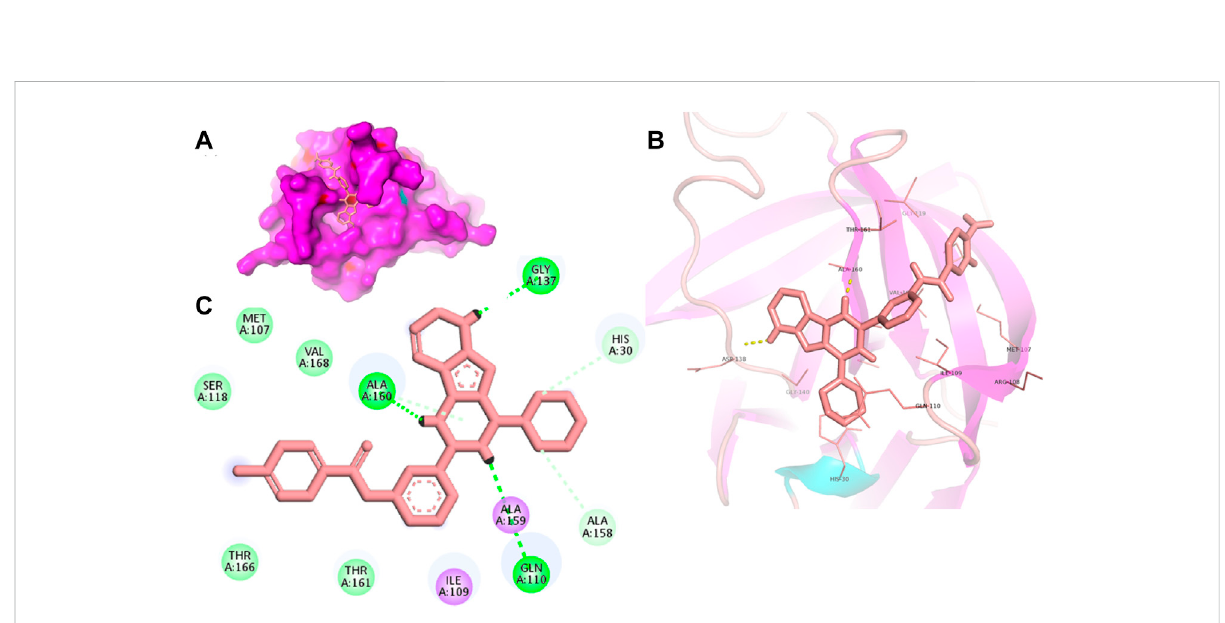
FIGURE 4 Surface view of YM201636 in the 3CLP binding pocket (A) , 3D (B) and 2D (C) interacting residues of 3CLP with